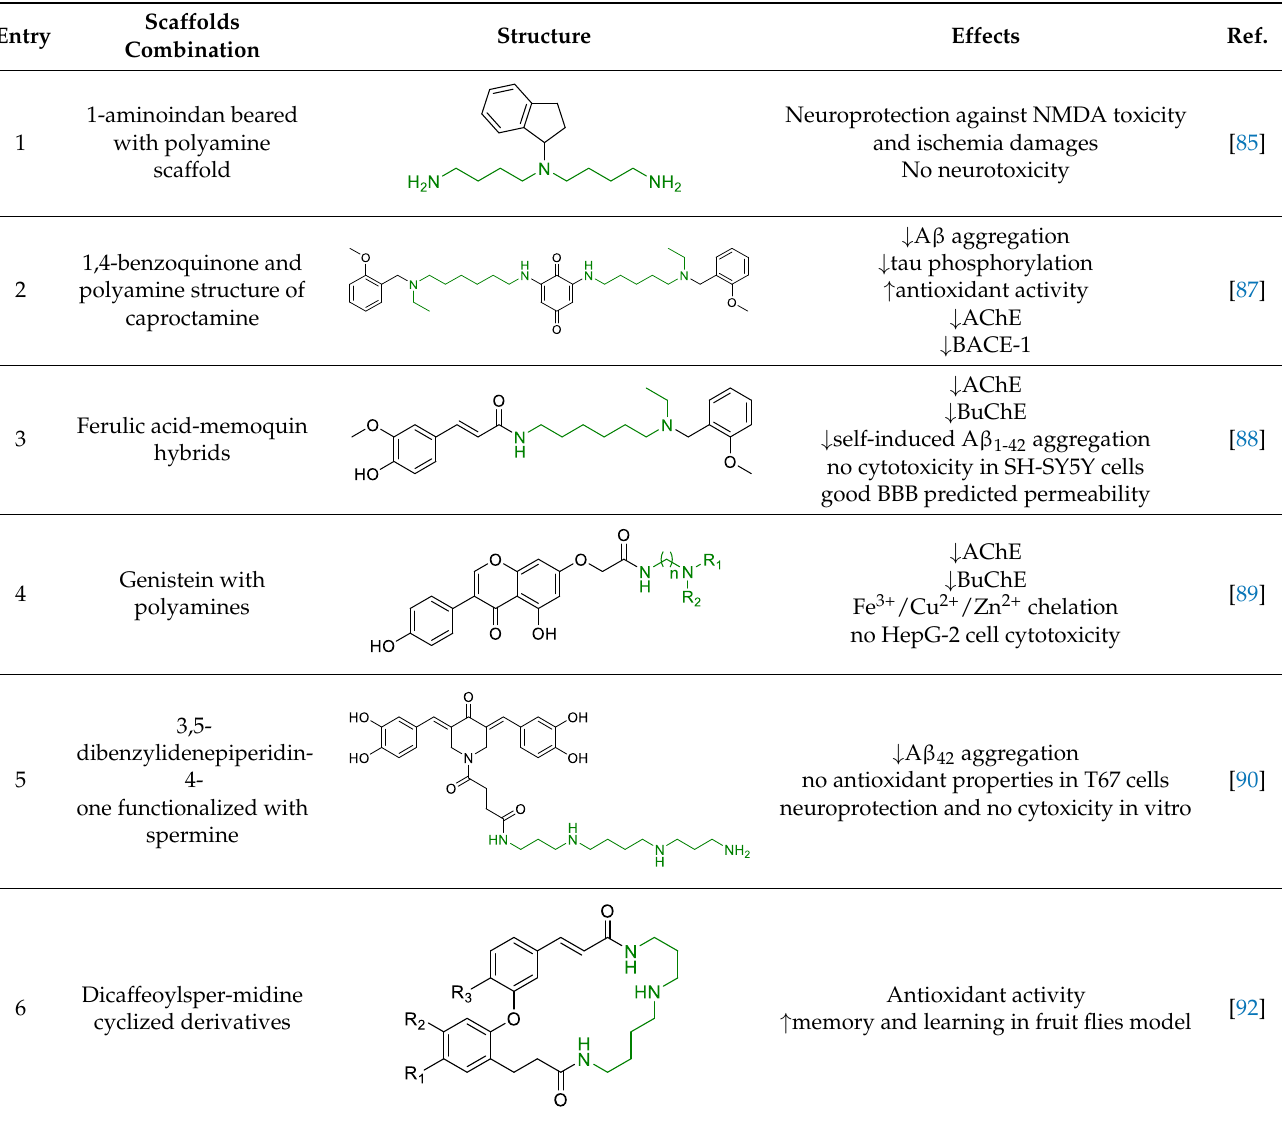
Table 2. Polyamines derivatives and their main biological effects.